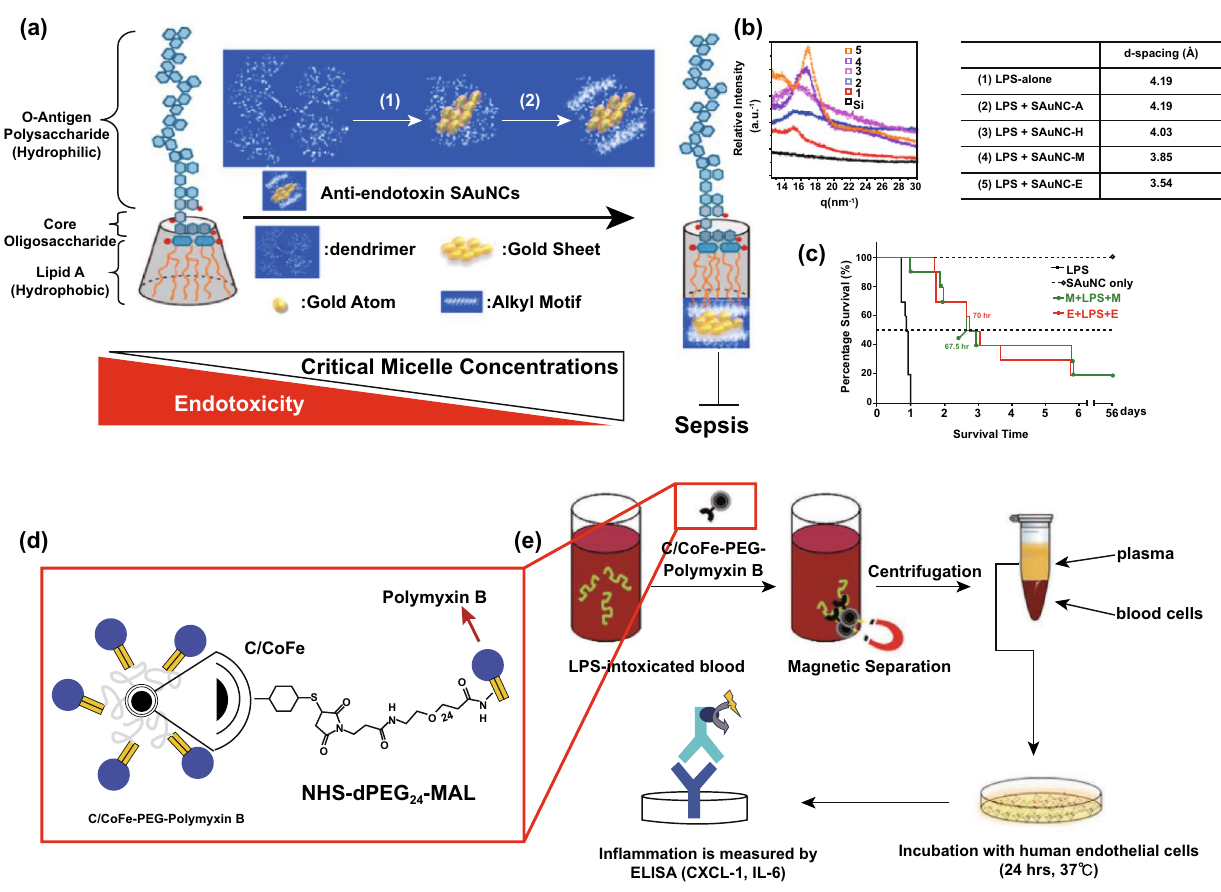
Fig. 14 Subnanometer gold clusters protect against endotoxin-induced sepsis by adhering to lipid A. a Fabrication of SAuNCs and the LPS neutralization mechanisms. b d -spacing determination of lipid A in the presence of the different SAuNCs, the table summarizes the d -spacing distance under each condition. c Survival rates of LPS-induced septic undergone various treatments, the dashed line represents the half percent- age survival. M and E indicate SAuNC-M and SAuNC-E, respectively. Reproduced with permission from Ref. [57]. Copyright 2018 American Chemical Society. Magnetic separation-based blood purification for endotoxin removal during sepsis management. d Schematic structure of C/ CoFe-PEG-Polymyxin B. e Schematic illustration of the in vitro blood purification step using C/CoFe-PEG-Polymyxin B. Reproduced with per- mission from Ref. [228]. Copyright 2013 John Wiley and Sons,